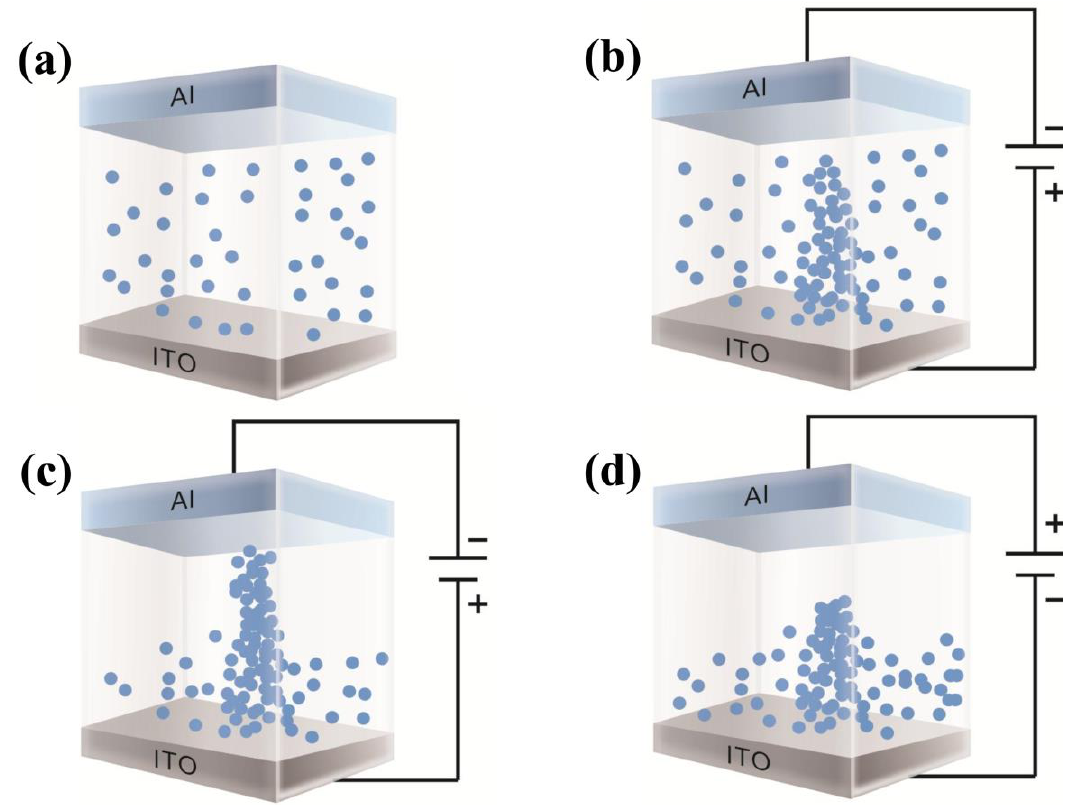
Figure 9. Schematic diagram of the resistive switching mechanism of the Al/ Bombyx mori body fluid film/ITO biomemristor: ( a ) OFF; ( b ) SET; ( c ) ON; ( d ) RESET.